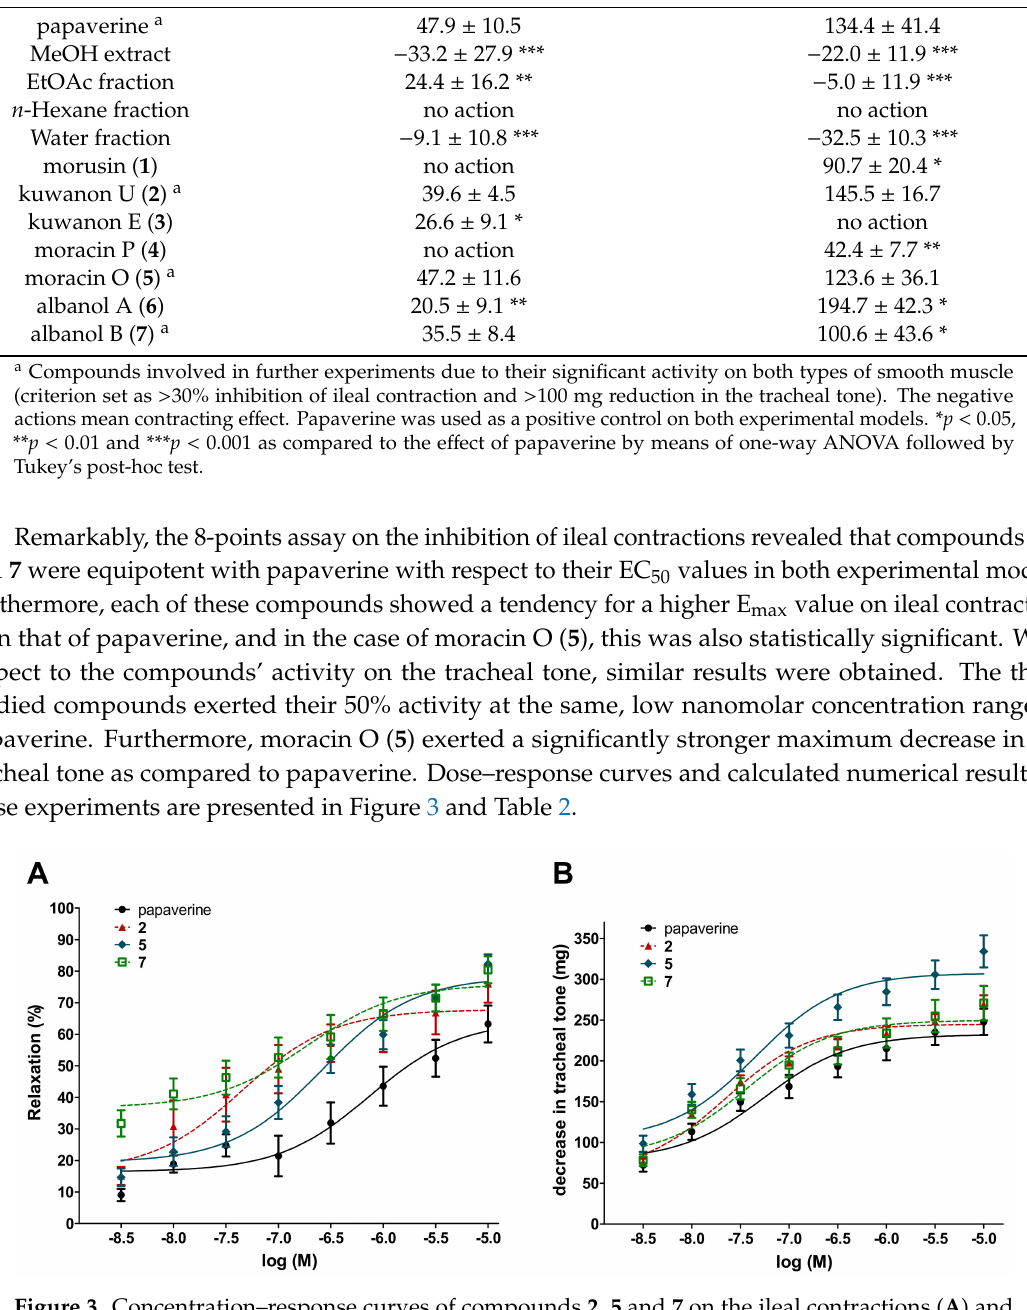
Figure 3. Concentration–response curves of compounds 2 , 5 and 7 on the ileal contractions ( A ) and tracheal tone ( B ) of isolated rat smooth muscles. Papaverine was used as a positive control. All the compounds elicited a relaxing e ff ect on ileal smooth